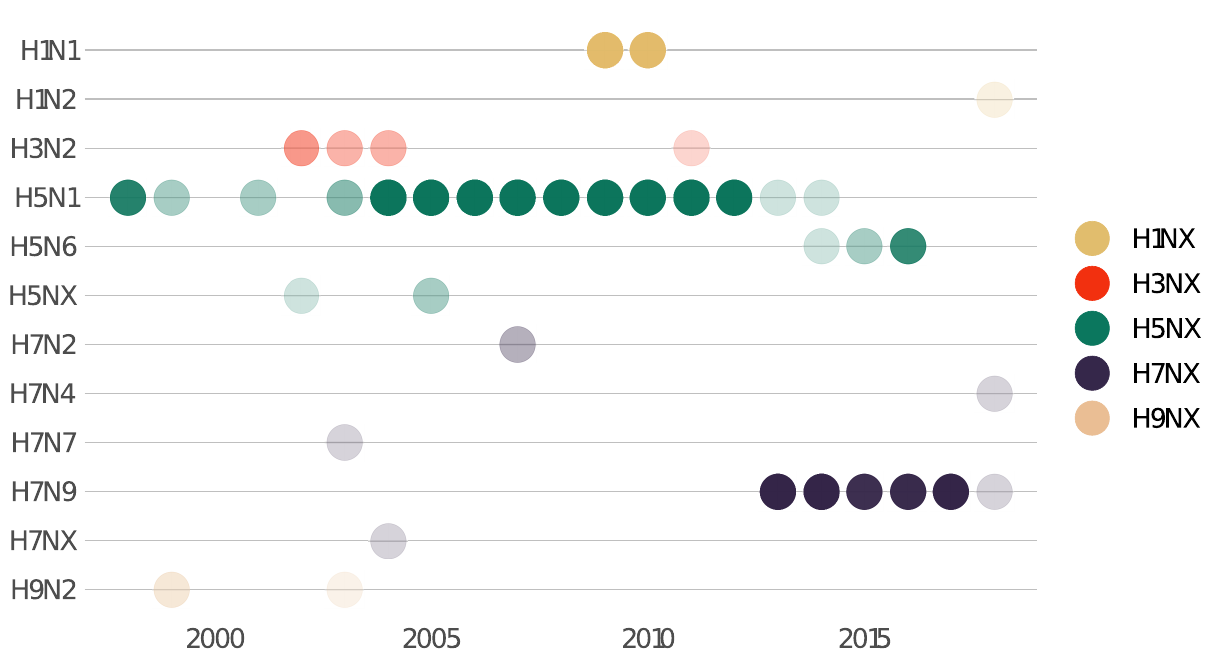
Fig 3. Influenza subtypes represented in the DONs shift over time. Each dot represents a year with at least one notification; opacity is proportional to the number of DON reports for that subtype in each year. Note that some reports do not specify a relevant subtype.